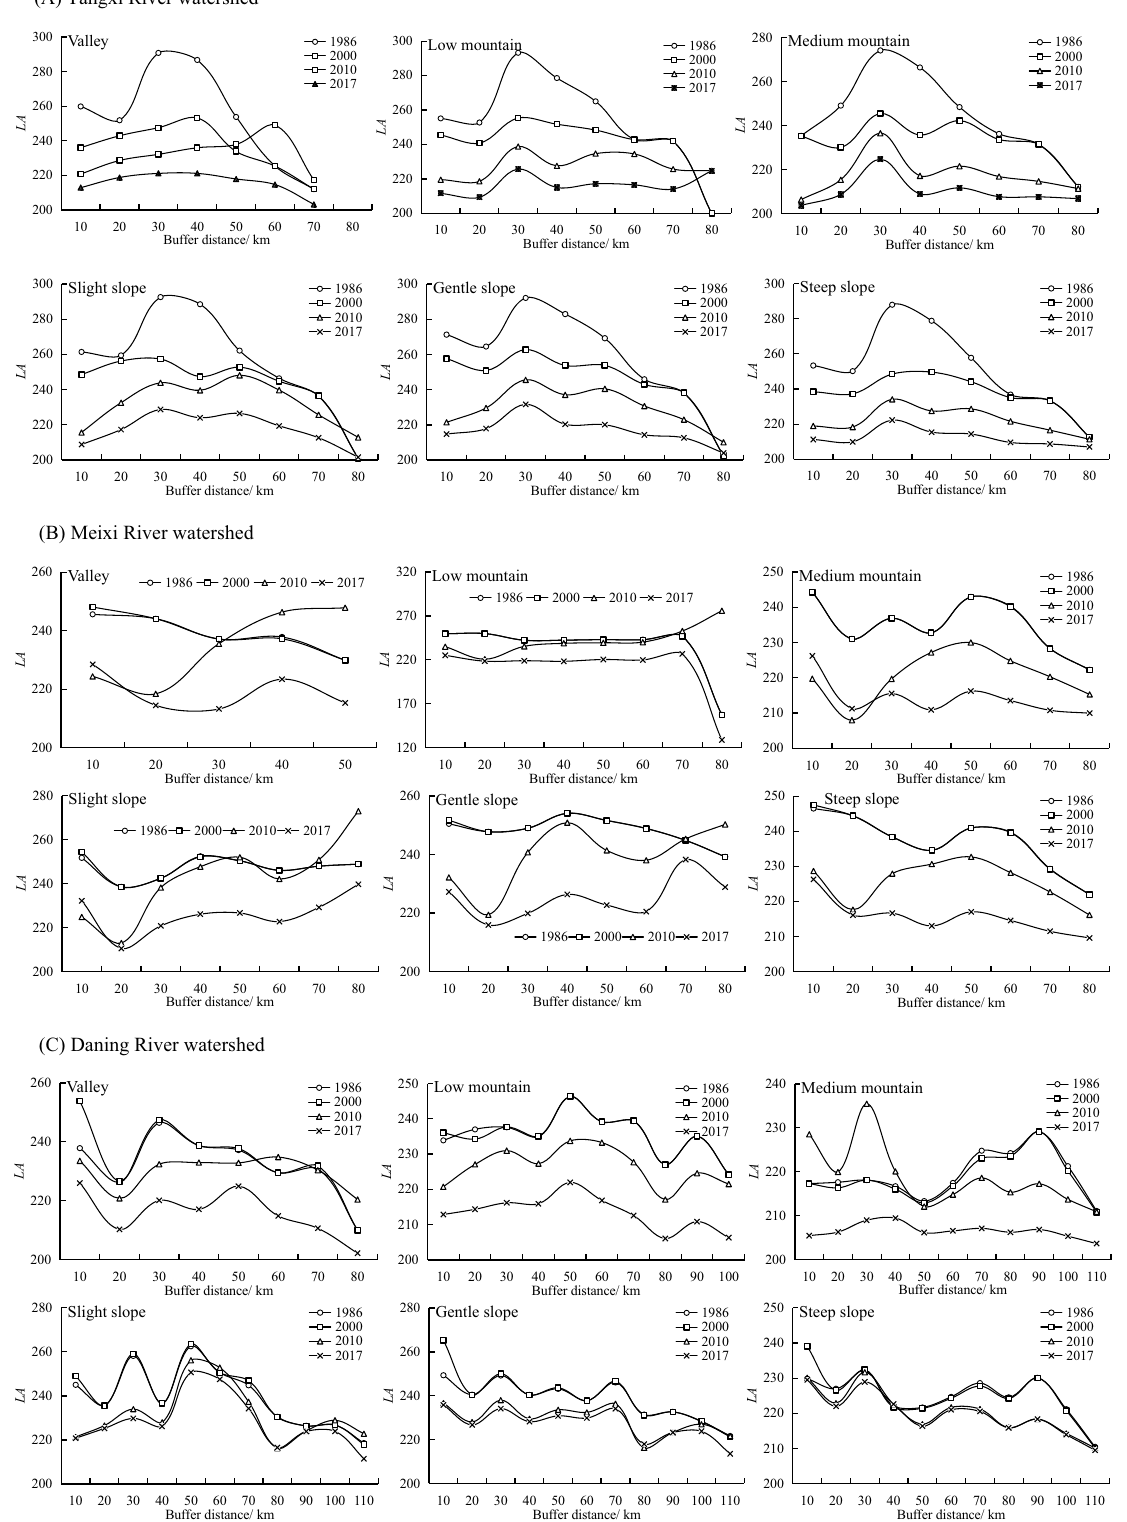
Figure 7. Comparison of LA in different buffer zones of watersheds from 1986 to